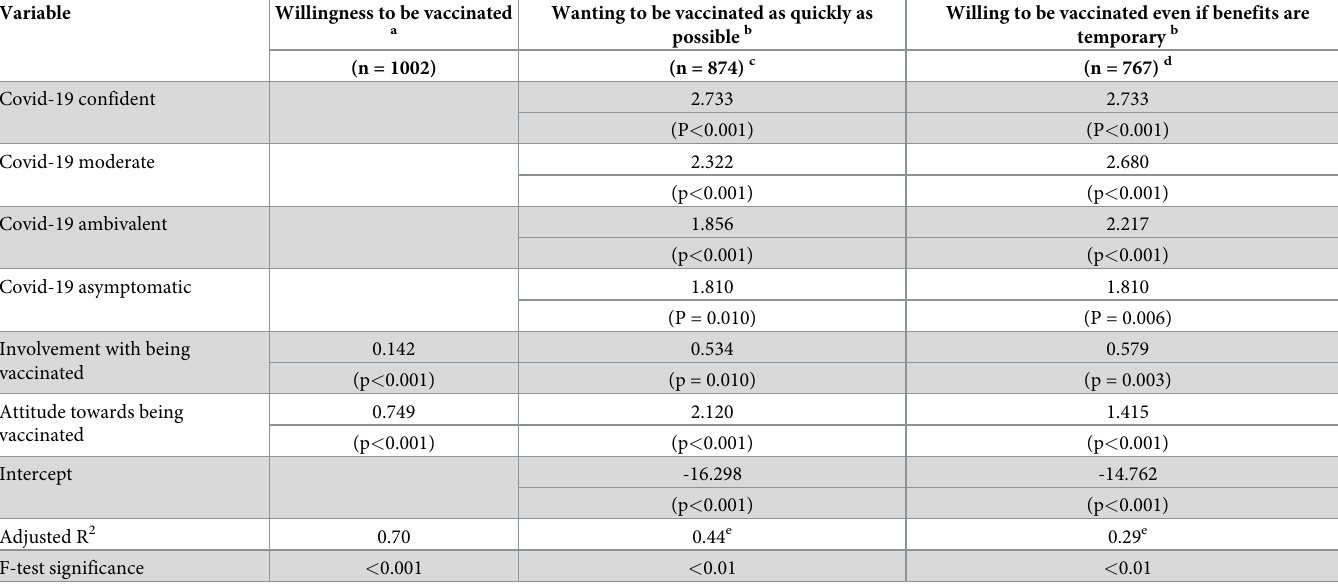
Table 13. Parameter estimates for willingness to be vaccinated for